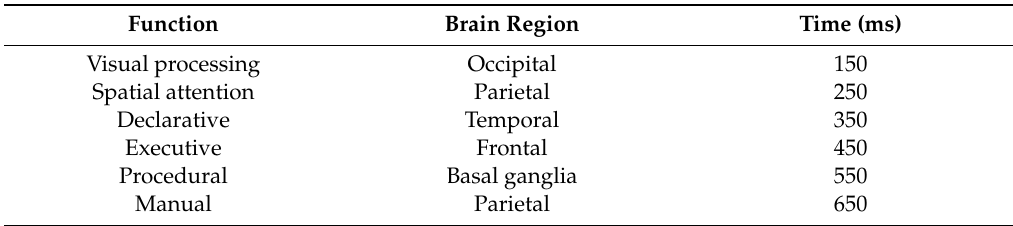
Table 1. Simulated locations and predicted timing of spiking occurrence according to the present adapted Python ACT–R architecture.